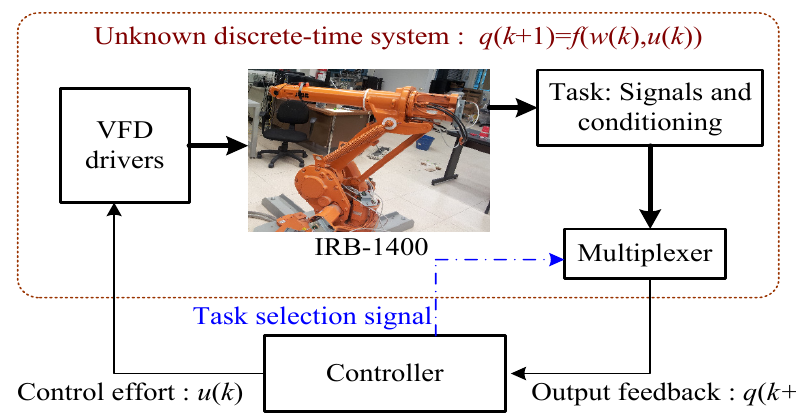
Figure 1. Discrete-time robotic control system block diagram. VFD, variable-frequency